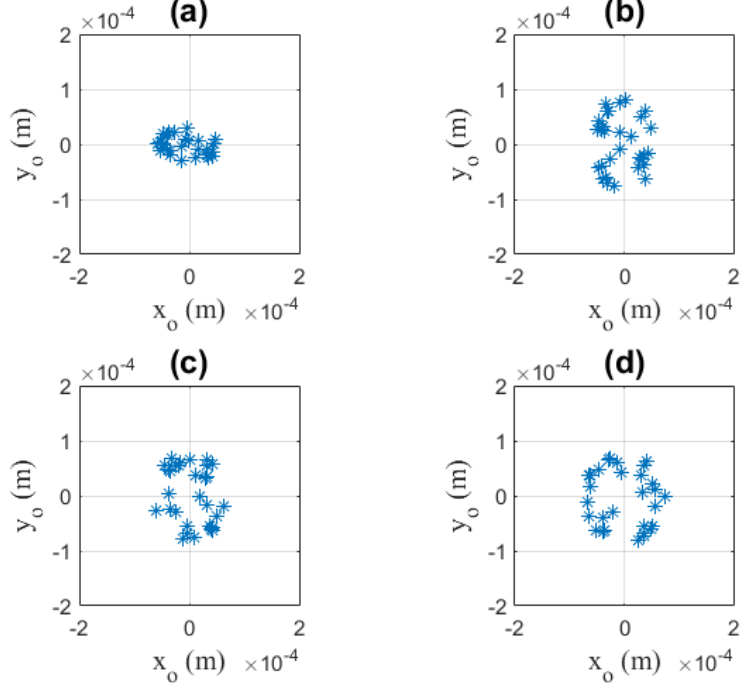
Figure 13. Particles 1 ( a ), 2 ( b ), 3 ( c ), and 4 ( d ) represented by an ensemble of coherent point emitters randomly located on the binarized shapes obtained in Figures 9c, 10c, 11c, and 12c, respectively.